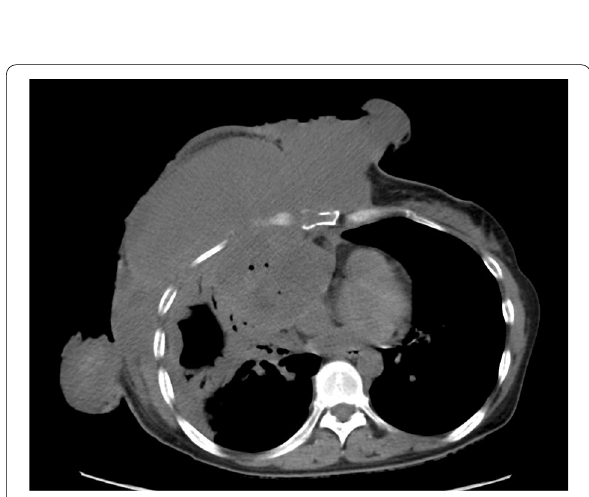
Fig. 7 Computed tomography showed a rapid increase in right chest wall tumors and pleural